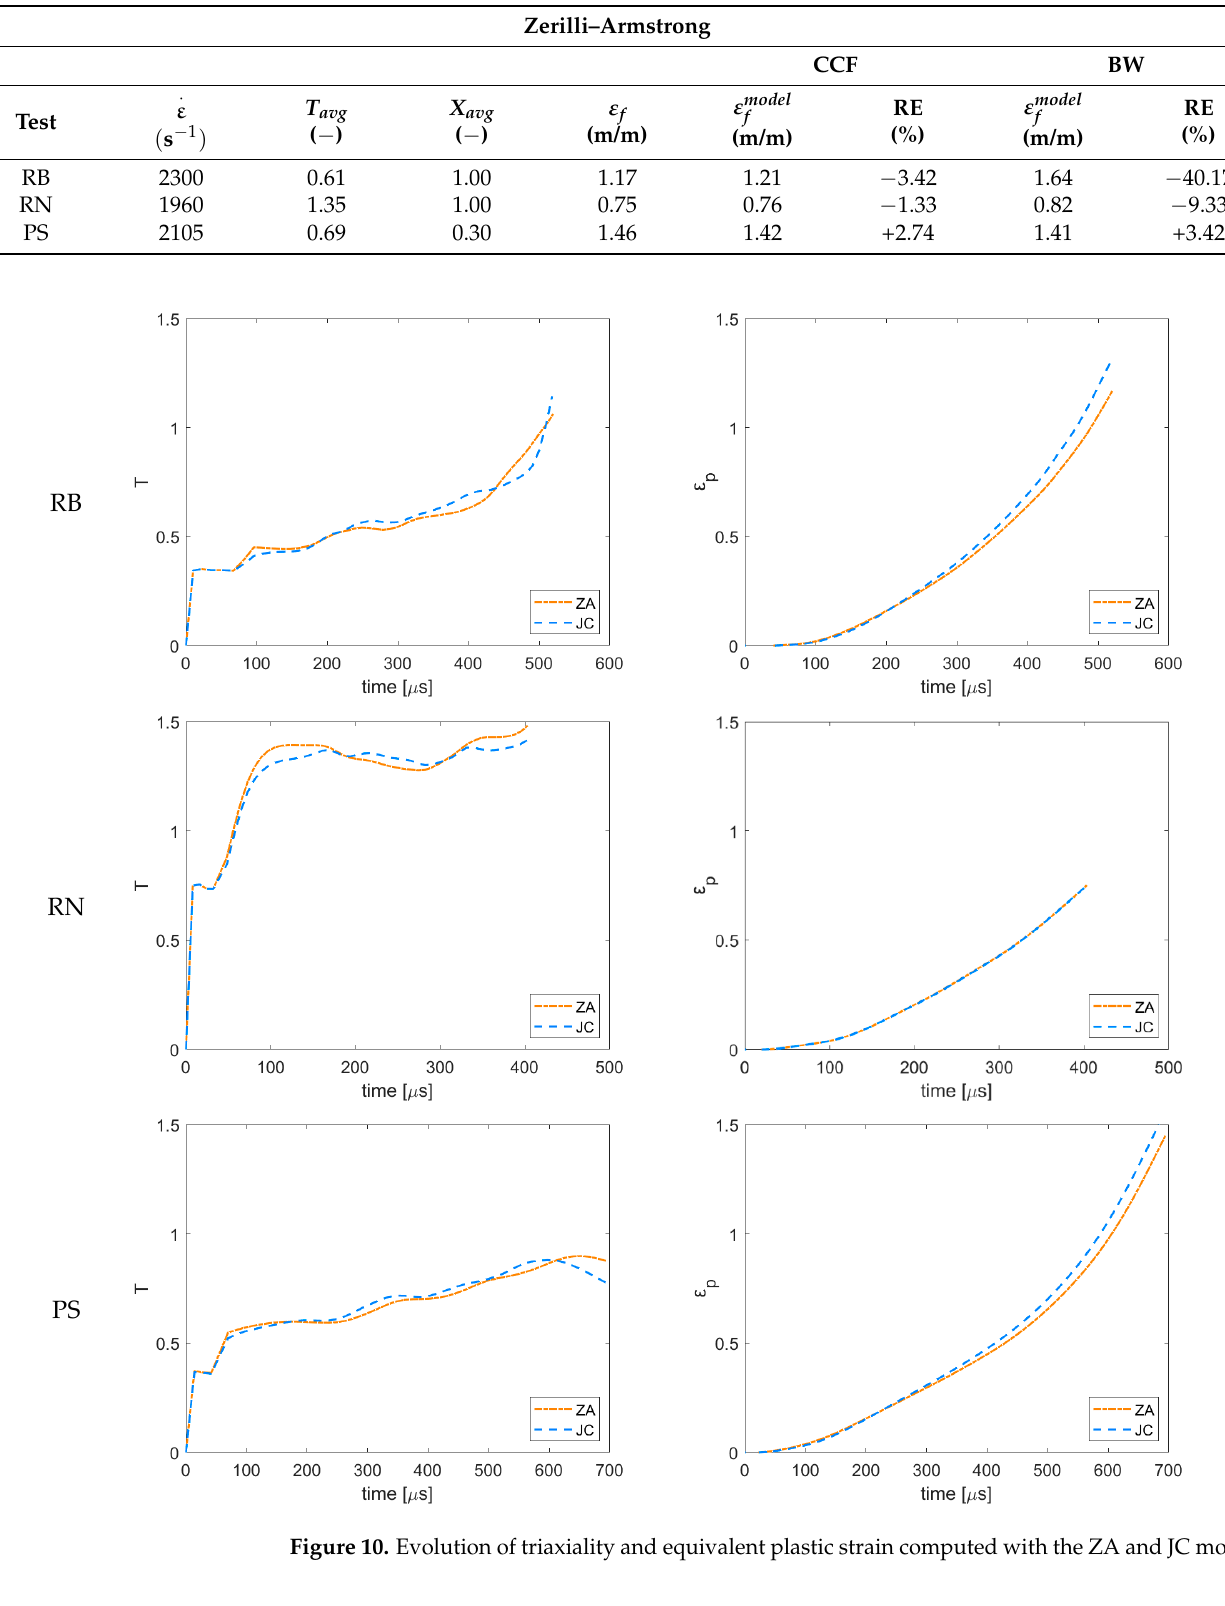
Table 6. Numerical results, ZA model: strain rate ( at fracture ( ε f ), strain at fracture ( ε model damage models.